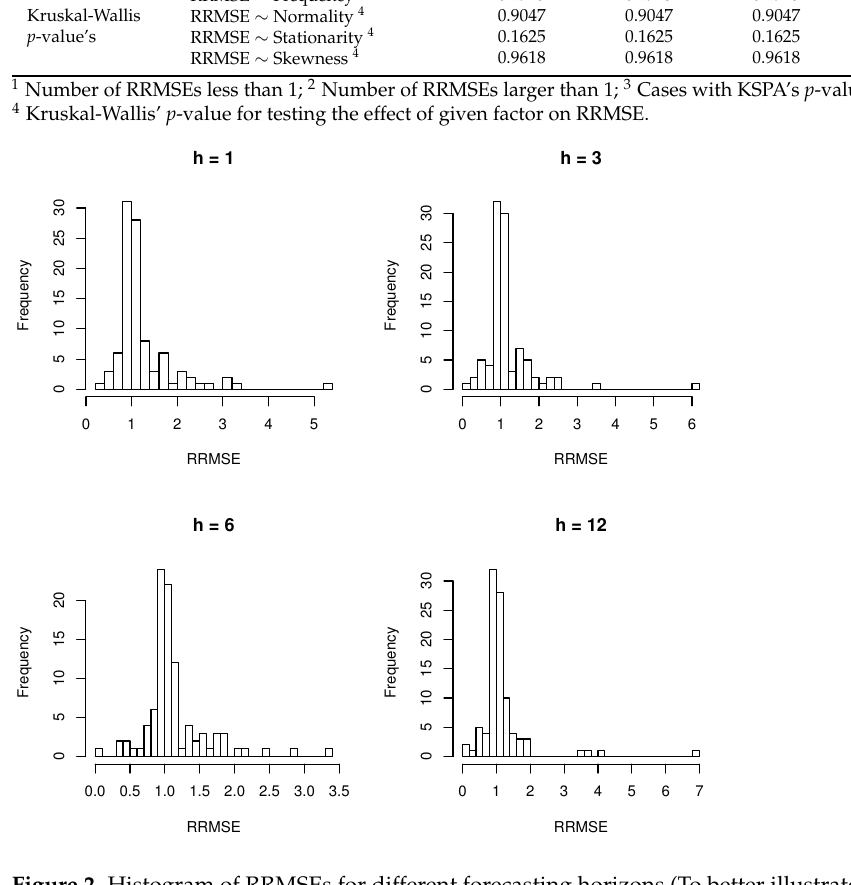
Figure 2. Histogram of RRMSEs for different forecasting horizons (To better illustrate the data, one extreme value is removed for h = 6 and two extreme values are removed for h =